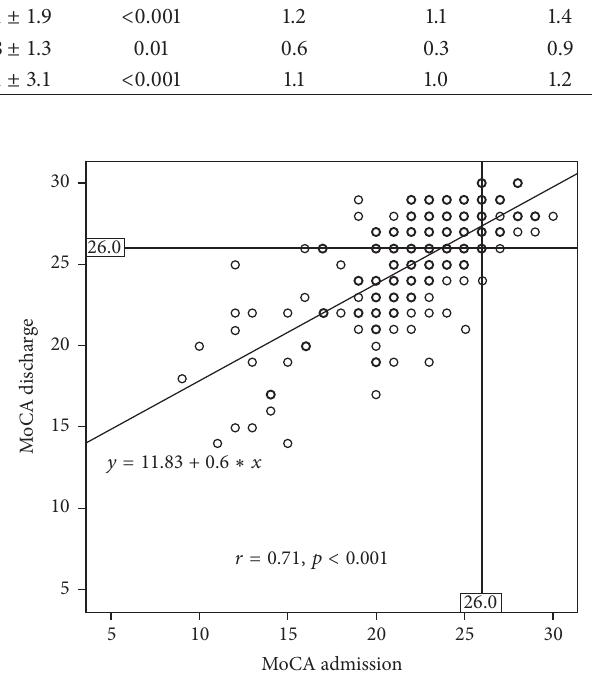
Figure 1: Plot of MoCA scores on admission against MoCA scores at discharge.